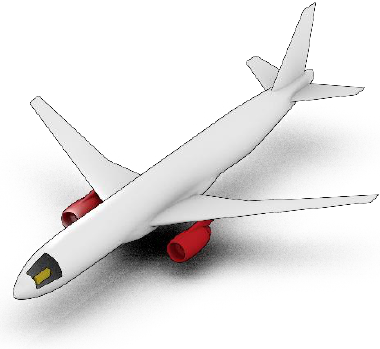
Figure 2. Reference example of a regional jet aircraft, with the engines and OBS highlighted.